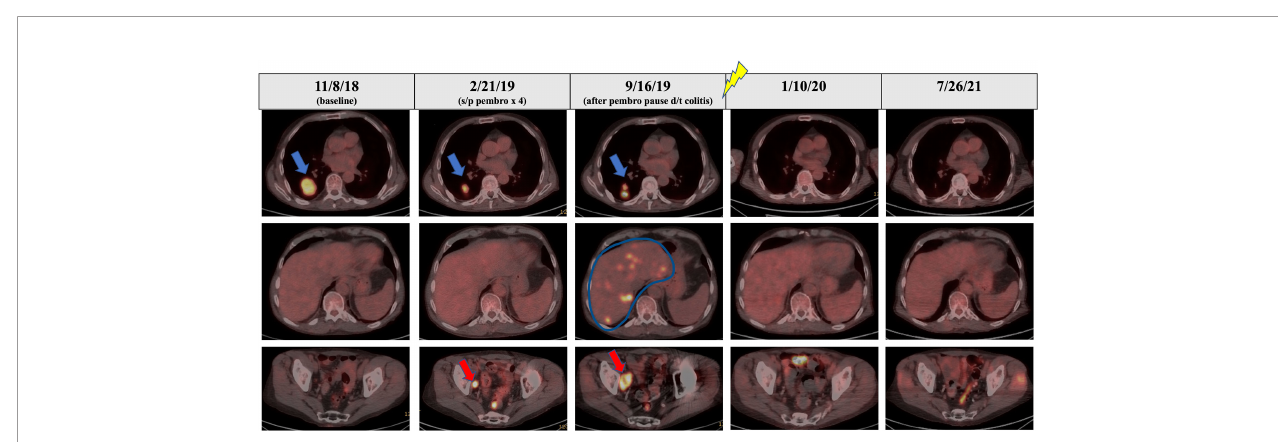
FIGURE 3 | PET/CT scans over the course of the patient ’ s treatment. The blue arrow in the top panel shows RLL nodule with good response to initial pembrolizumab monotherapy from the baseline scan in November 2018. The red arrow in the bottom panel shows a site of progression in the right pelvic sidewall through initial pembrolizumab monotherapy representing mixed response to initial pembrolizumab monotherapy. Palliative RT was delivered October 2019 to sacral metastasis (signi fi ed by lightning symbol). The blue line in the middle panel outlines multifocal progressive disease in the liver seen on the September 2019 PET/CT after break in therapy due to pembrolizumab-related colitis. PET/CT in January 2020 and September 2021 show complete metabolic